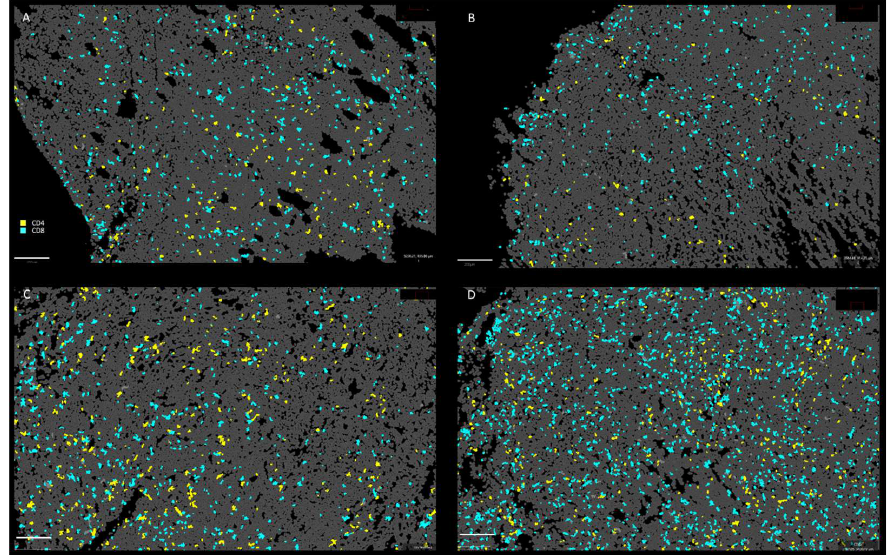
Figure 6. Tumor tissue sections prepared from antibiotic-treated (ABT) and untreated mice after either bacterial (EcN) or PBS injections stained with CD4 and CD8 antibodies and analyzed by CODEX multiplexed imaging. CD4+ and CD8+ cells in tumor tissue sections (presented areas correspond to areas in Figure 3). ( A ): PBS— PBS-injected group; ( B ): ABT PBS —antibiotic-pretreated and PBS-injected group; ( C ): EcN —EcN/pMUT-gfp Kn r injected group; ( D ): ABT EcN —antibiotic-pretreated and EcN/pMUT-gfp Kn r injected group. All pictures in this set were taken at the same magnification. Scale bars represent 200 µm.